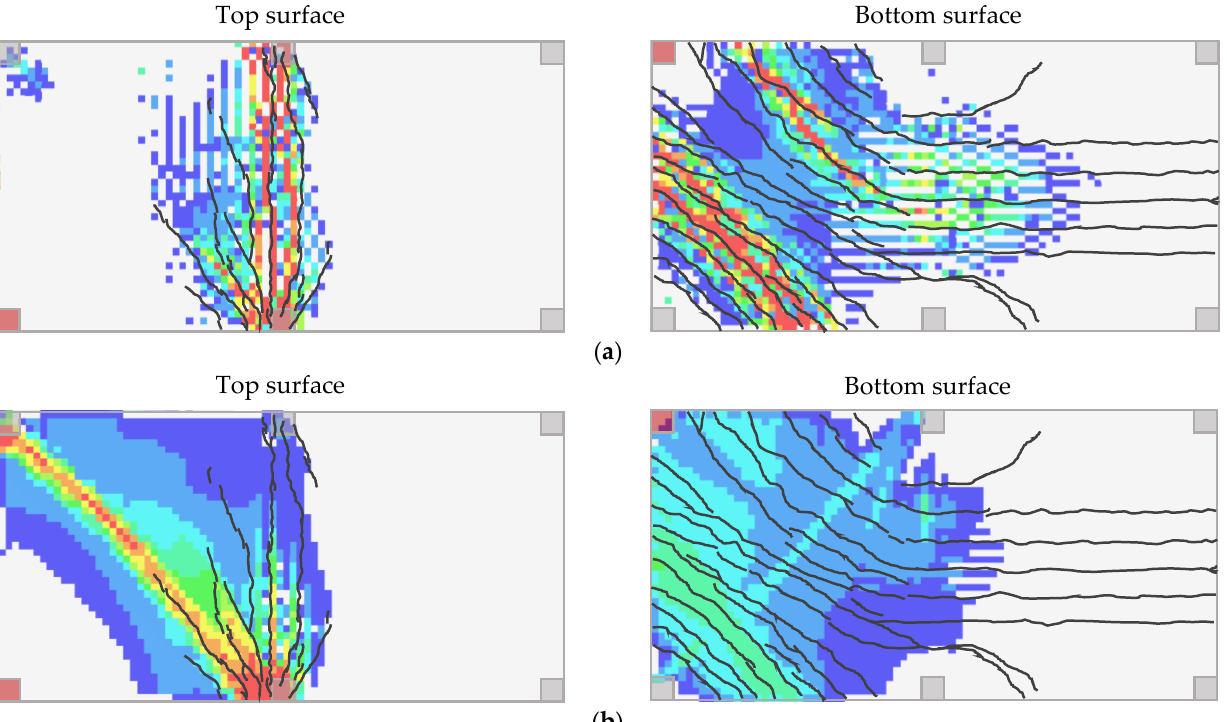
Figure 6. Comparison of damage accumulated in the flat slab from nonlinear dynamic ( a ) and nonlinear static ( b ) analyses with the crack patterns from the experiment.